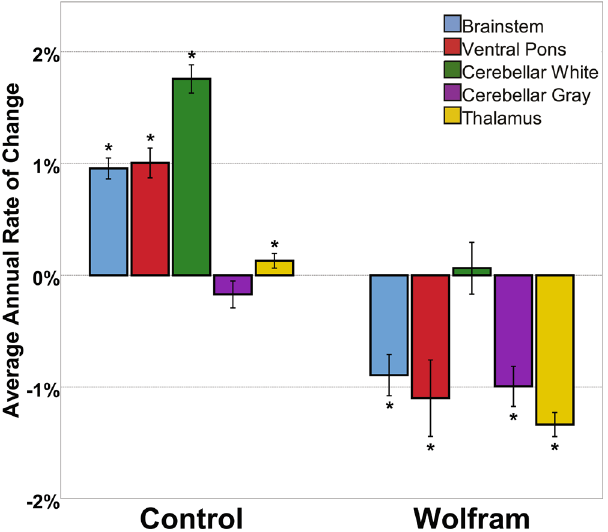
Figure 4. Mean ( ± SEM) estimated annual percent rate of change for regions of interest. Each individual’s estimated slopes from the mixed model analysis were scaled by their average volumes to calculate annual percent change for each region. Mean annual percent change for each region across groups is shown with the control group on the left and the Wolfram group on the right. Error bars represent standard error of the mean. * p < 0.05, one tailed t-test vs. 0.